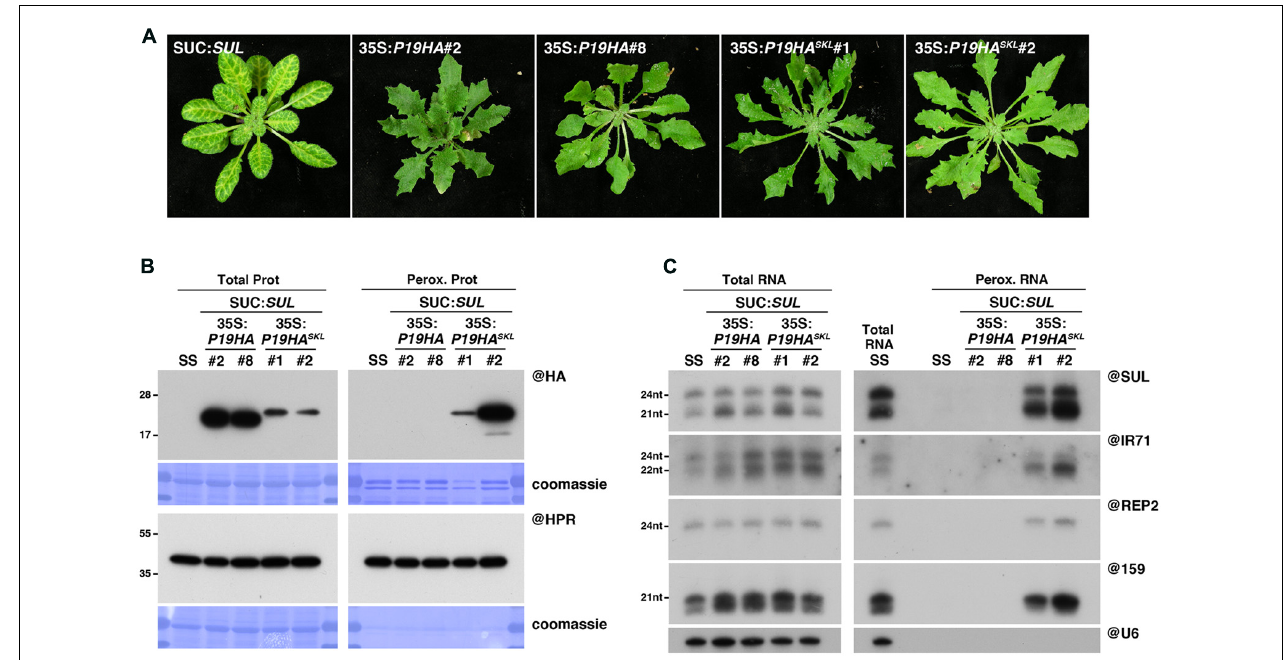
FIGURE 2 | Peroxisomal targeting of P19HA leads to import of 21, 22, and 24nt small RNAs into these organelles. (A) Photos of SUC: SUL, 35S: P19HA /SUC: SUL (transgenic lines #2 and #8) and 35S: P19HA SKL /SUC: SUL (transgenic lines #1 and #2) plants used for peroxisome isolation. (B) Western analysis of plant peroxisomal marker hydroxypyruvate reductase (@HPR) and P19HA/P19HA SKL (@HA) in total (left) and peroxisomal (perox. right) fractions obtained from the plants described in (A) . Note that more peroxisomal protein was loaded to detect P19HA/P19HA SKL than to detect HPR. (C) Northern analysis of small RNAs (SUL, IR71, REP2, miR159) in total (left) and peroxisomal (right) fractions from the plants described in (A) was obtained by sequential rounds of probing and stripping the same membranes. Northern analysis was performed on a low-resolution gel. Accumulation of snU6 was used as RNA loading control, while coomassie staining was used as protein loading control. Figure source data can be found with the Supplementary